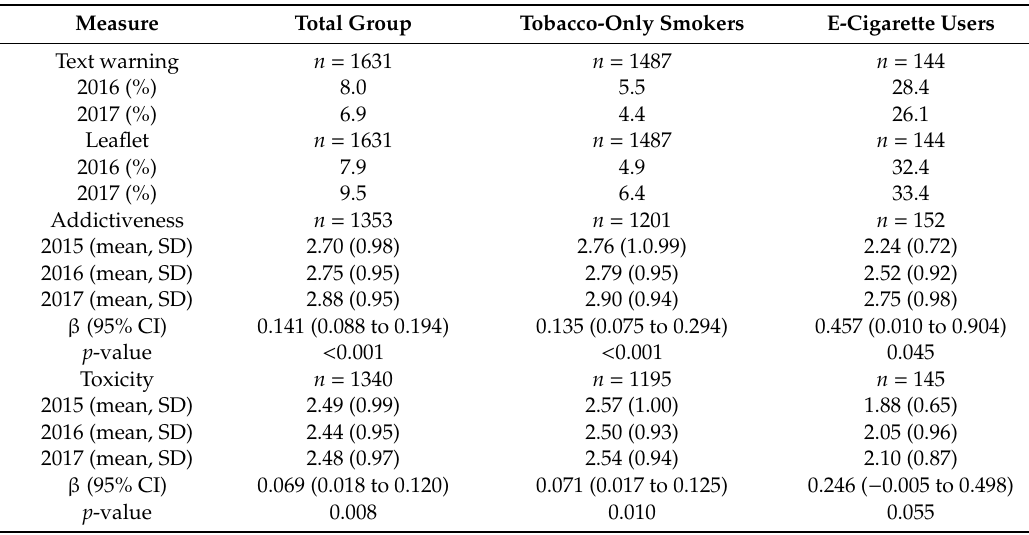
Table 1. Scores on noticing the text warning and the leaflet in 2016 and 2017, and scores on perceptions of the addictiveness and toxicity of e-cigarettes between 2015 and 2017 with betas of trends resulting from GEE (Generalized Estimating Equations), including Confidence Intervals (CIs).